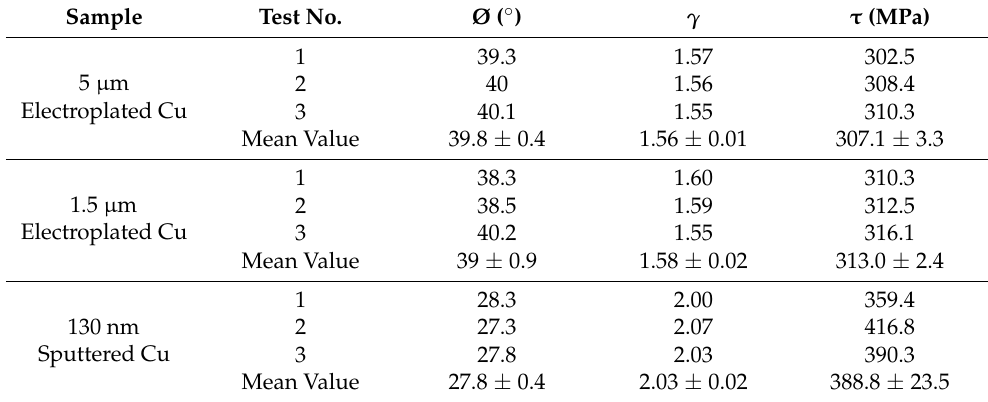
Table 1. Cutting results for Cu thin